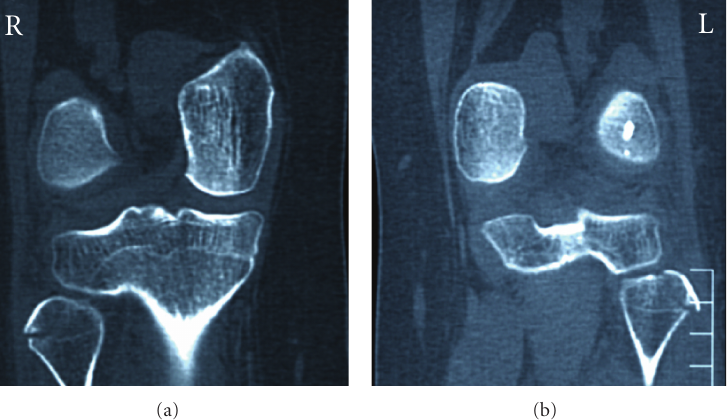
Figure 2: CT of both knees. The displacement of the fractures is minimal (2mm for the right fibular head and 3mm for the left).